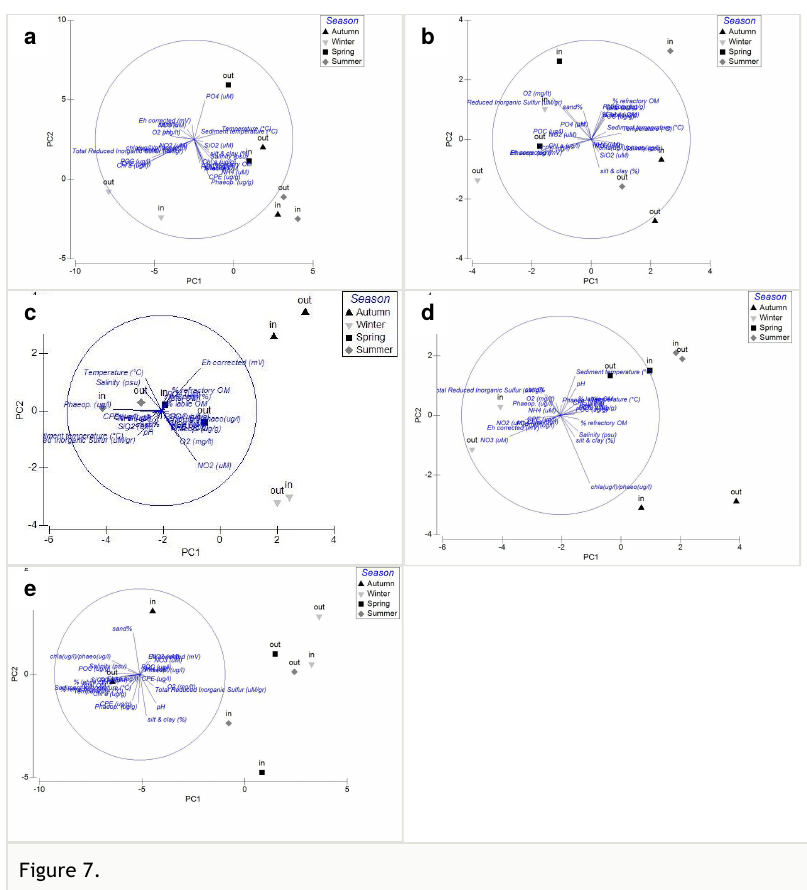
PCA plots of the stations based on the environmental data of four sampling seasons